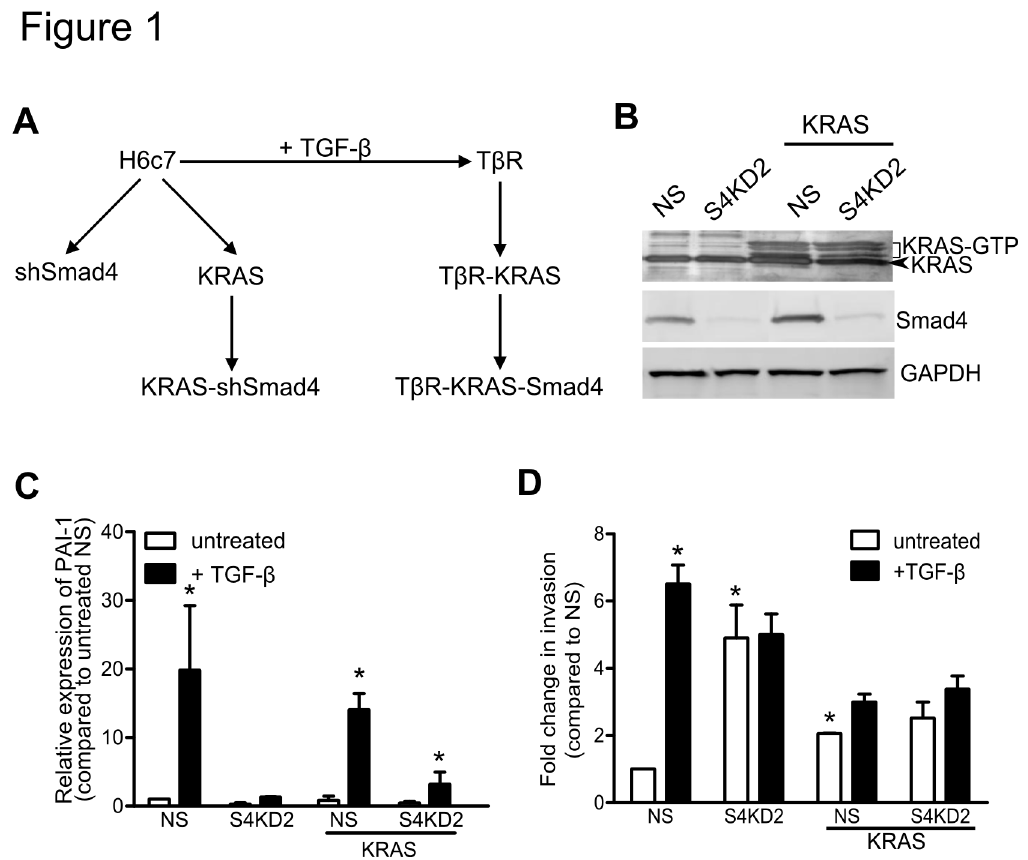
Figure 1. Smad4 knockdown and KRAS G12V expression in the H6c7 cell line. ( A ) A schema of introducing KRAS G12V and Smad4 loss using the H6c7 cell line to produce the shSmad4, H6c7 KRAS shSmad4, TβR, TβR-KRAS , and TβR-KRAS -Smad4 cell lines. ( B ) Immunoblot of RAS-GTP, KRAS, and Smad4. GAPDH was used as a loading control. ( C ) PAI-1 mRNA expression after 48 hours of TGF-β stimulation (n=3). ( D ) Invasion assays through Matrigel coated membranes incubated with and without TGF-β (n=6). (* denotes significant differences between the test and control NS samples, and between treatment and no treatment groups two-way ANOVA and Bonferroni’s post hoc tests or paired student t-test; p<0.05; data are presented as mean ± SEM) .